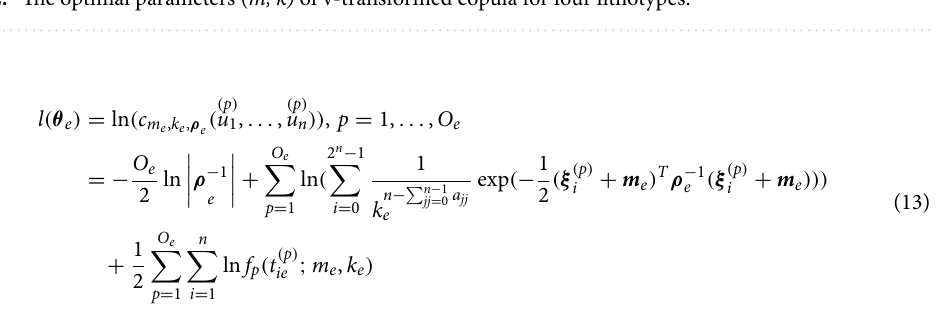
Table 2. The optimal parameters ( m, k) of v-transformed copula for four lithotypes.